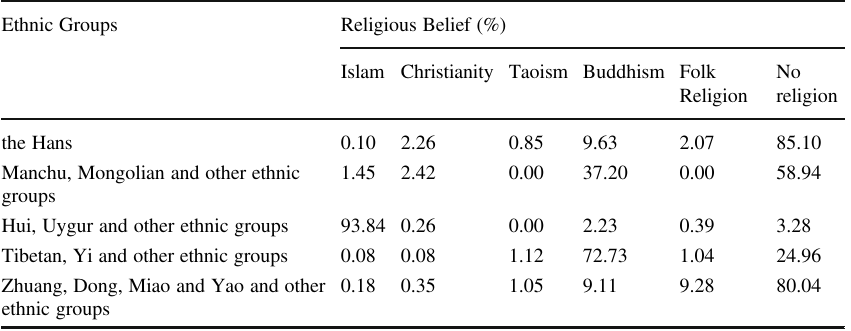
Table 2 Correlation Analysis on Ethnic Groups and Their Religious Beliefs Ethnic